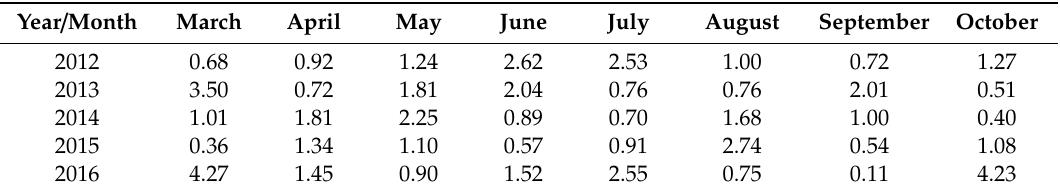
Table 1. Hydrothermal index Sielianinov Index (K) in the growing season (March to October) in 2012–2016 (recorded at the agrometeorological observatory in Złotniki,